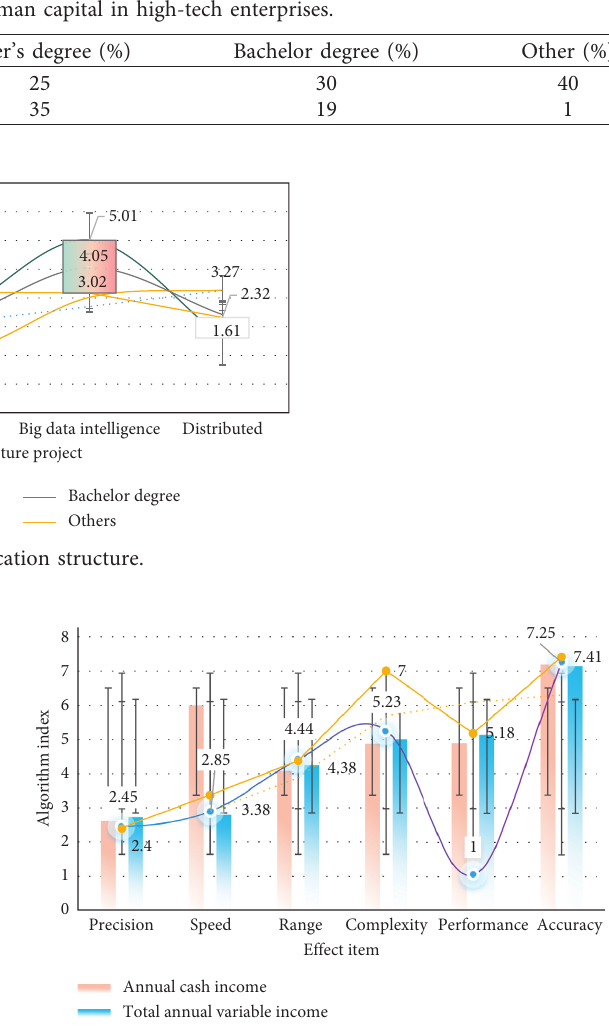
Figure 14: The proportion of human resource cost is